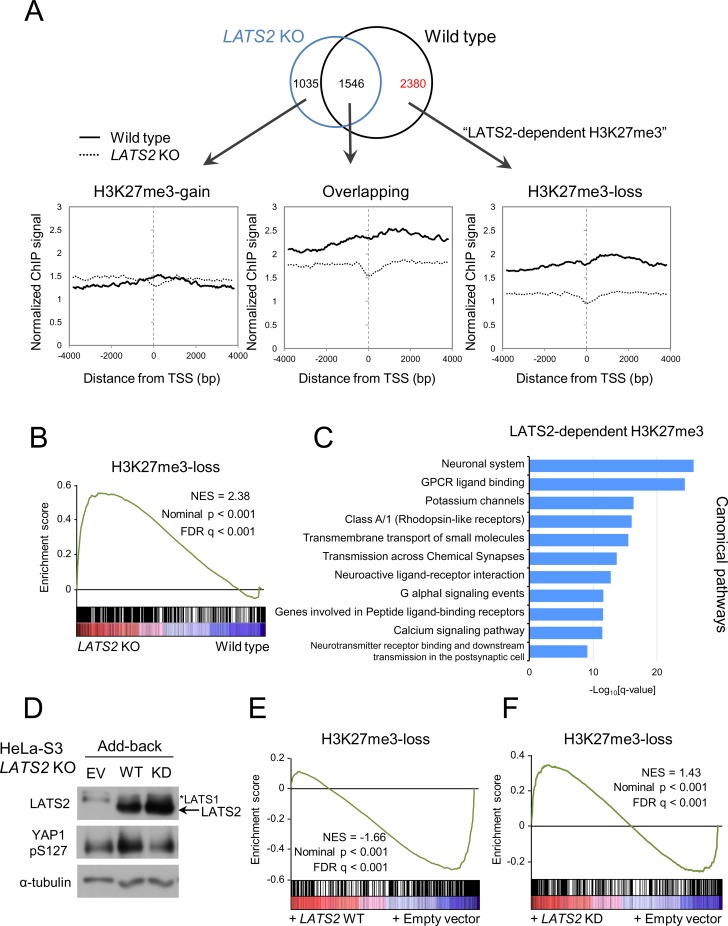
ChIP-seq profiling for LATS2-dependent H3K27me3 targets.(A) Top: Venn diagram showing the overlap of genes with H3K27me3 peaks within ±5 kb of the TSS in wild type (blue) and LATS2 KO HeLa-S3 cells (black). Bottom: Aggregate plots of H3K27me3 ChIP-seq signals centered at TSSs of RefSeq genes for each module of wild type (solid line) and LATS2 KO HeLa-S3 cells (dashed line). (B) GSEA of LATS2 KO HeLa-S3 cells, for genes with LATS2 KO–responsive H3K27me3 marks in their promoters. Genes are ranked by fold change, derived from the RNA-seq experiment (KO vs. wild type). A positive enrichment score indicates increased expression after LATS2 KO. (C) GO enrichment analysis of canonical pathways for LATS2-dependent H3K27me3 targets. The x-axis represents statistical significance. The y-axis represents gene sets belonging to 'canonical pathways' from MSigDB (Broad Institute). (D) Western blotting of whole cell lysate of rescued LATS2 KO HeLa-S3 cells. Phosphorylated YAP was blotted as an indicator of LATS2 kinase activity. EV, empty vector. WT, kinase active. KD, kinase-inactive mutant. (E) GSEA of rescued LATS2 KO HeLa-S3 cells, for genes with LATS2-KO–responsive H3K27me3 marks in their promoters. Left: cells rescued by kinase active (WT) LATS2. Right: cells rescued by kinase-inactive (KD) LATS2. Genes are ranked by fold change, derived from the RNA-seq experiment (LATS2 add-back vs. empty vector). A positive enrichment score indicates increased expression upon LATS2 add-back.